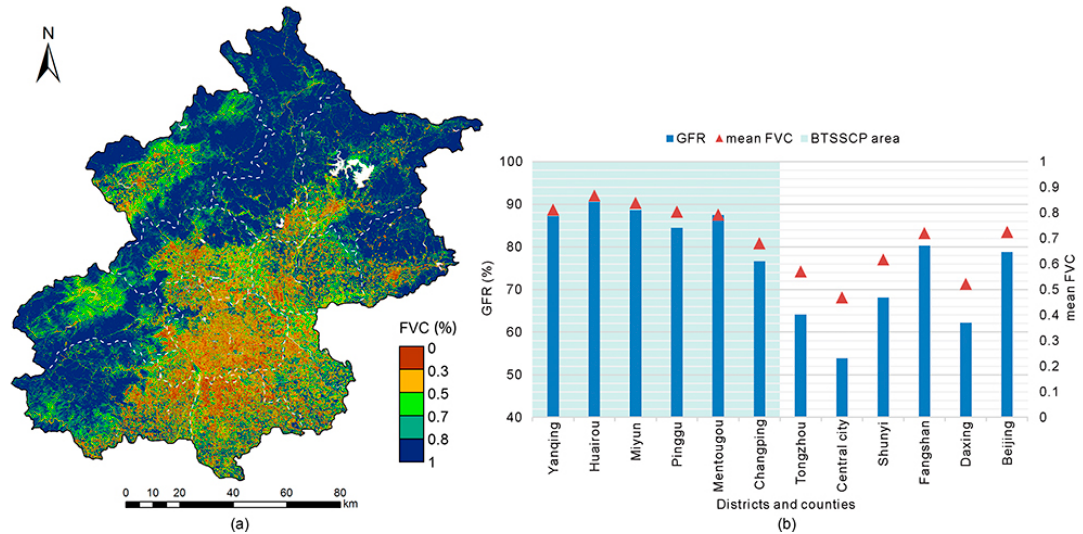
Figure 4. ( a ) The spatial distribution of FVC in Beijing. The map was created using ESRI ArcGIS 10.2. ( b ) The mean FVC/GFR of each county in 2015. The areas with a blue-green background color belong to the BTSSCP area.